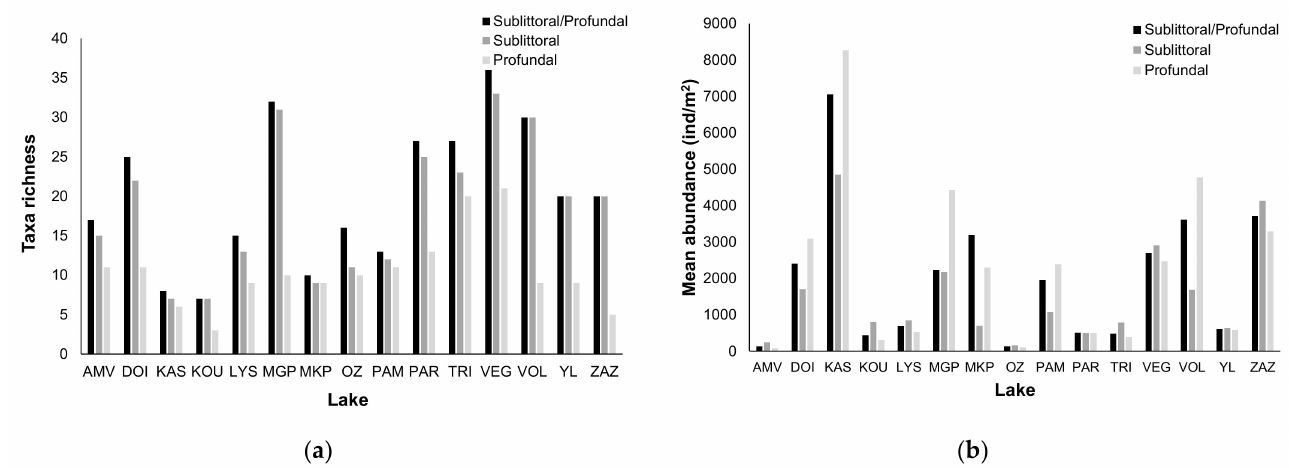
Figure 2. ( a ) Taxa richness and ( b ) abundance of benthic macroinvertebrates per lake zone (sublittoral and profundal) and in the combined sublittoral/profundal